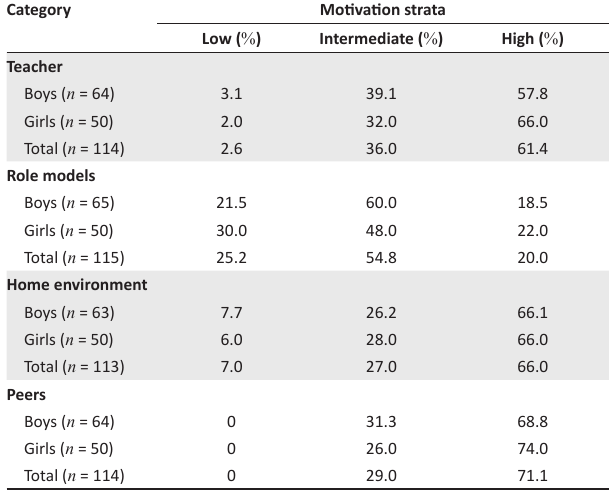
TABLE 1: Scores per motivation strata for each